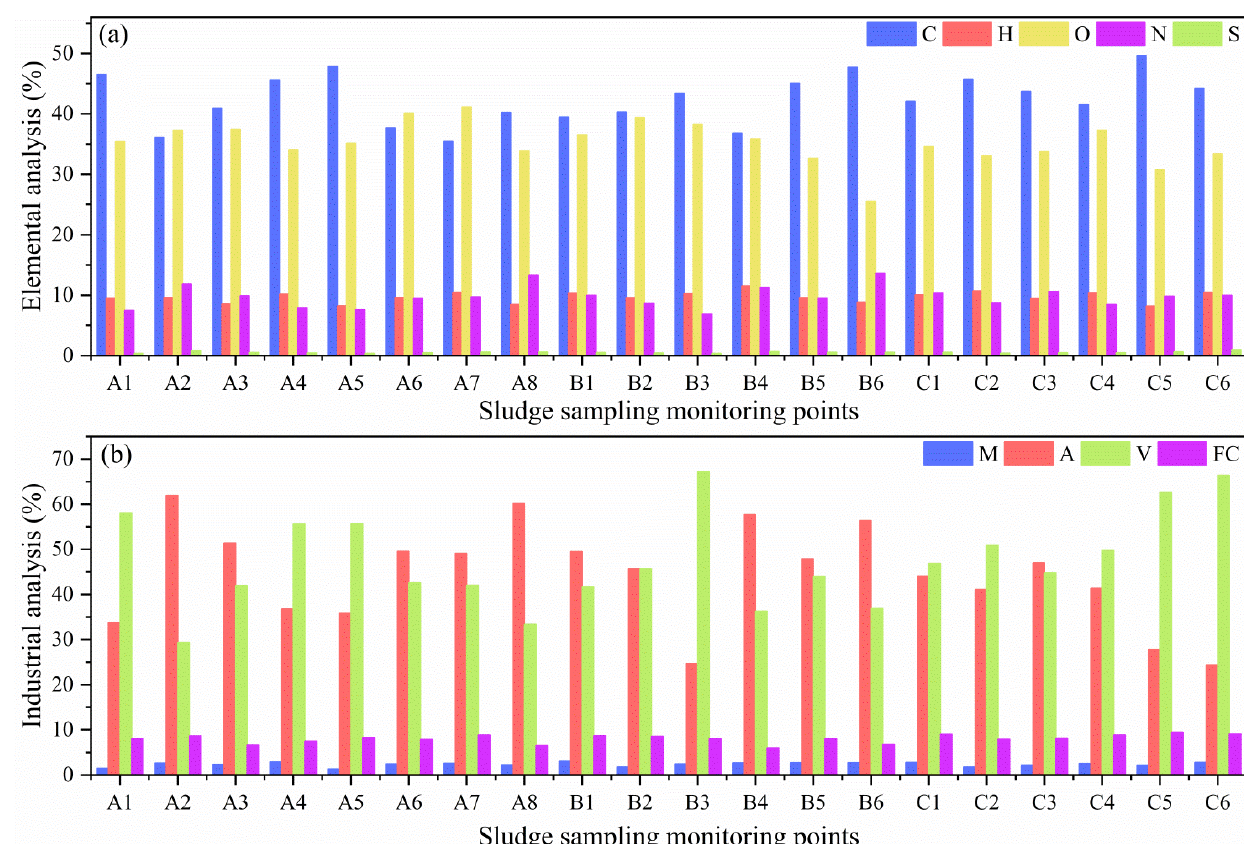
Figure 3. ( a ) Elemental analysis of MSS in Jiangsu; ( b ) industrial analysis of MSS in Jiangsu.